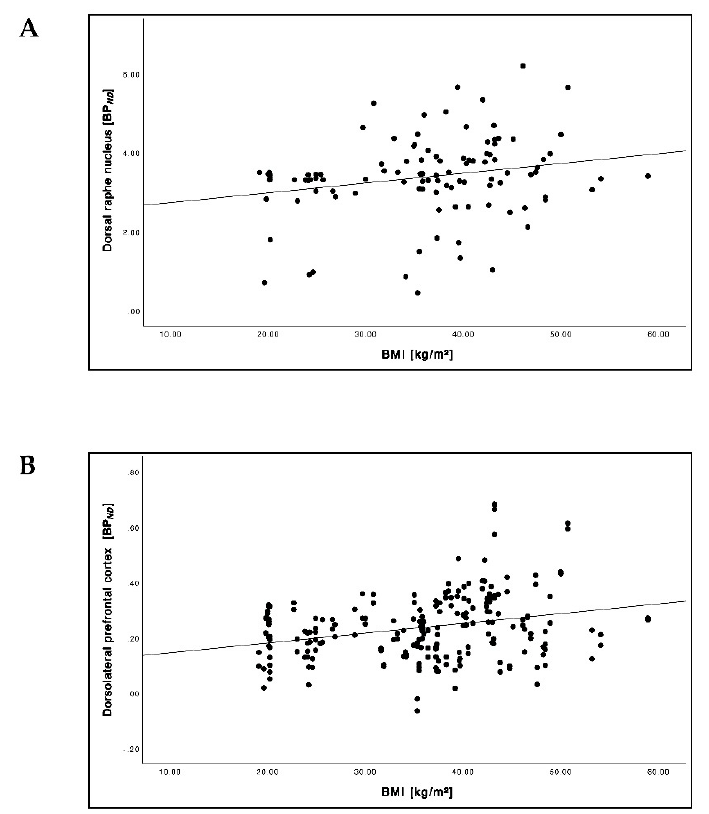
Figure 5. Relationship between BMI and 5-HTT BP ND across the cohort (pooled baseline and follow-up data) in the dorsal raphe nucleus (DRN) ( A ) and in the dorsolateral prefrontal cortex (dlPFC) ( B ).